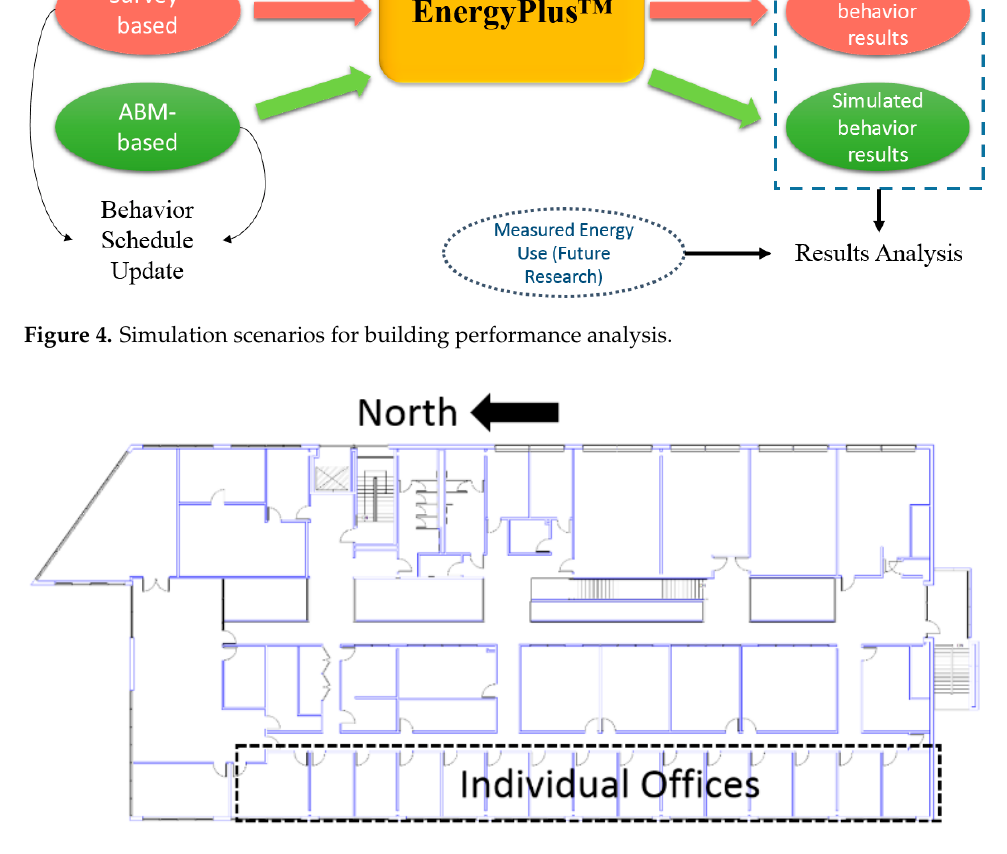
Figure 5. Building layout (third floor) and office rooms selected (specific locations are not shown for privacy) for simulation study.